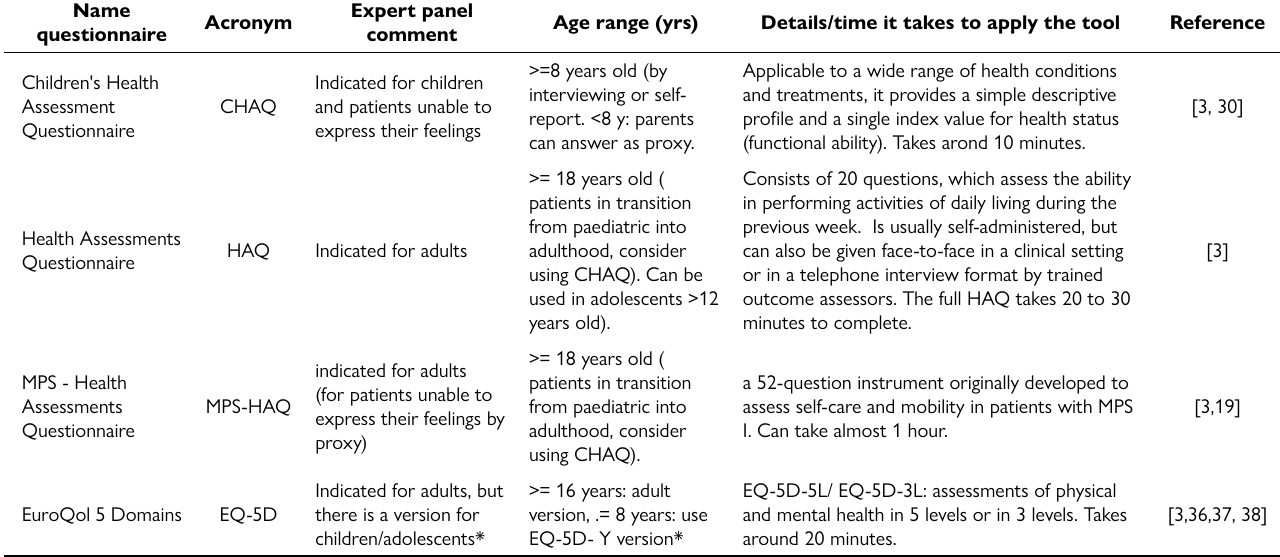
Table 1. Recommended tools for the assessment of HRQoL in MPS disorders